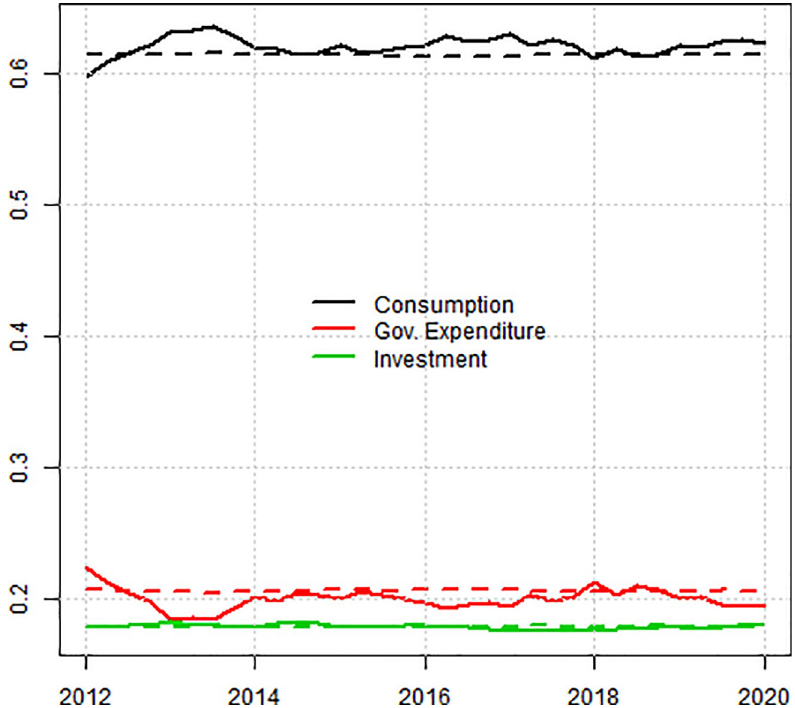
Fig 1. Simulated (dotted) and Polish (solid) time series used for calibration of the structure of GDP. Source: OECD quarterly national accounts and authors’ computations.